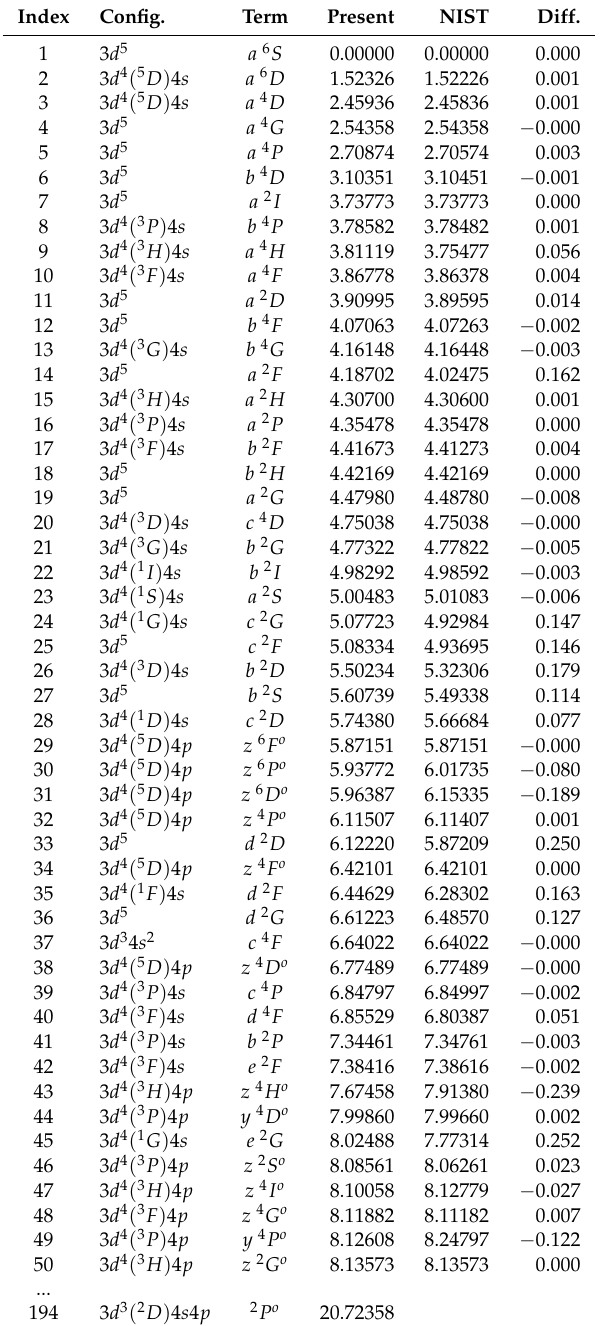
Table 3. Excitation energies (in eV) of the final residual Cr II states included into close-coupling